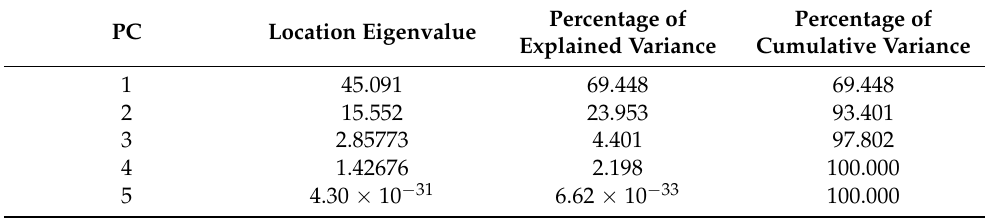
Table 2. Eigenvalues and percentages of explained variance for the Principal Components (PC) extracted for the distribution of chemical elements (in percentages) found on samples of the lichen Xanthoria parietina collected along an urban–rural gradient in the city of L’Aquila (Central Italy). Percentage of Percentage of PC Location Eigenvalue Explained Variance Cumulative Variance 1